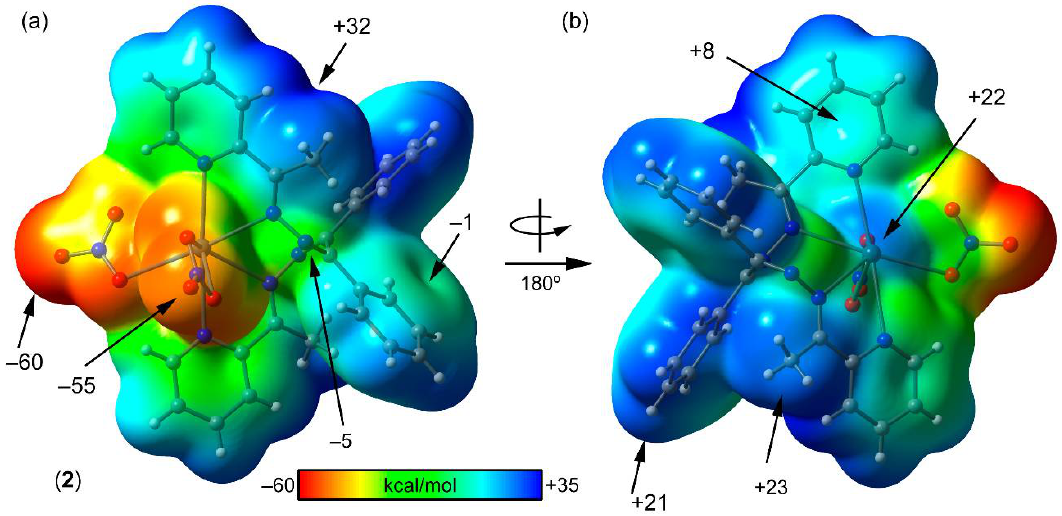
Figure 12. MEP surface (isosurface 0.001 a.u.) of the two sides ( a ) and ( b ) of compound ( 2 ) at the PBE1PBE-D3/def2-TZVP. The MEP values at selected points of the surface are given in kcal/mol.